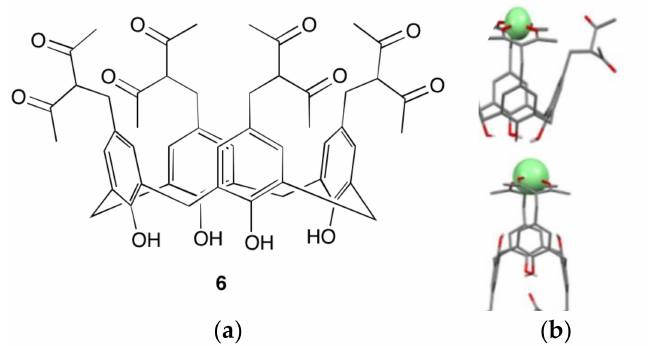
Figure 7. ( a ) The β -diketonate functionalised calix[4]arene 5 ; ( b ) A cartoon of the polyelectrolyte (PSS) stabilised nanoparticle with a core of Gd/Tb complexes of 6 , showing interaction with water molecules with Gd, and light with Tb. Reproduced under Creative Commons BY 4.0 from [41].